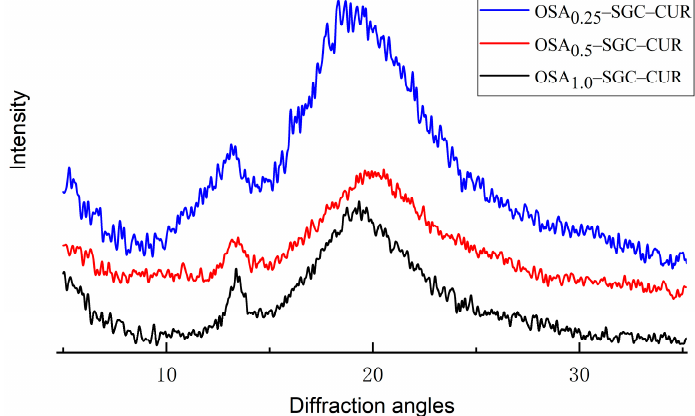
ff raction patterns of the curcumin and OSA–SGC–CUR inclusion Figure 8. X-ray diffraction patterns of the curcumin and OSA–SGC–CUR inclusion complexes. Figure 8. X-ray di Figure 8. X-ray diffraction patterns of the curcumin and OSA – SGC – CUR inclusion complexes. Figure 8. X-ray diffraction patterns of the curcumin and OSA–SGC–CUR inclusion complexes.